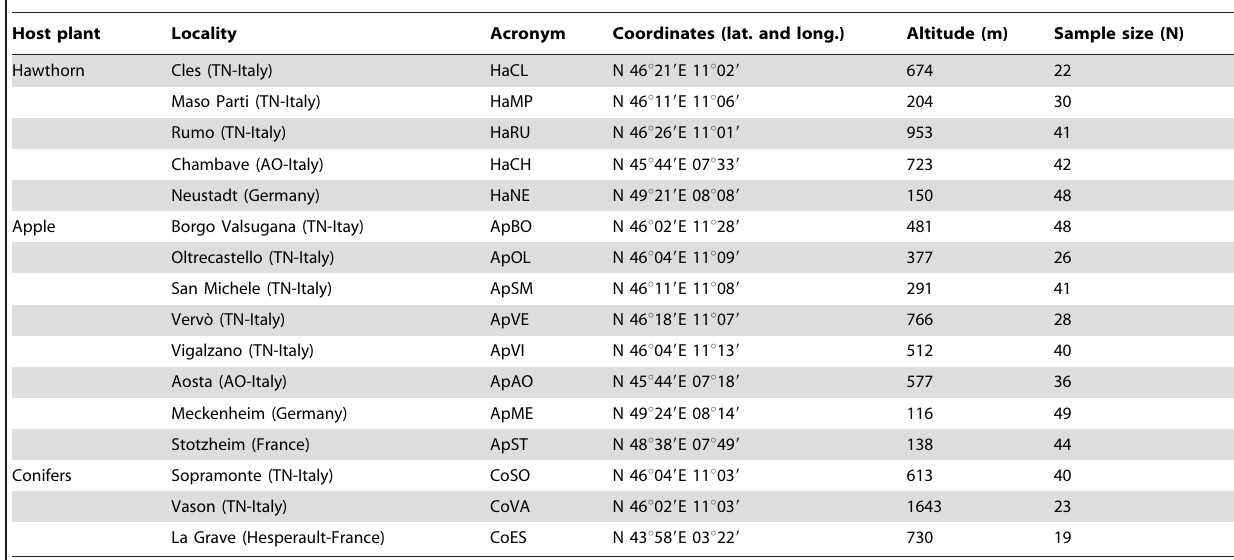
Table 1. Cacopsylla melanoneura sampling.